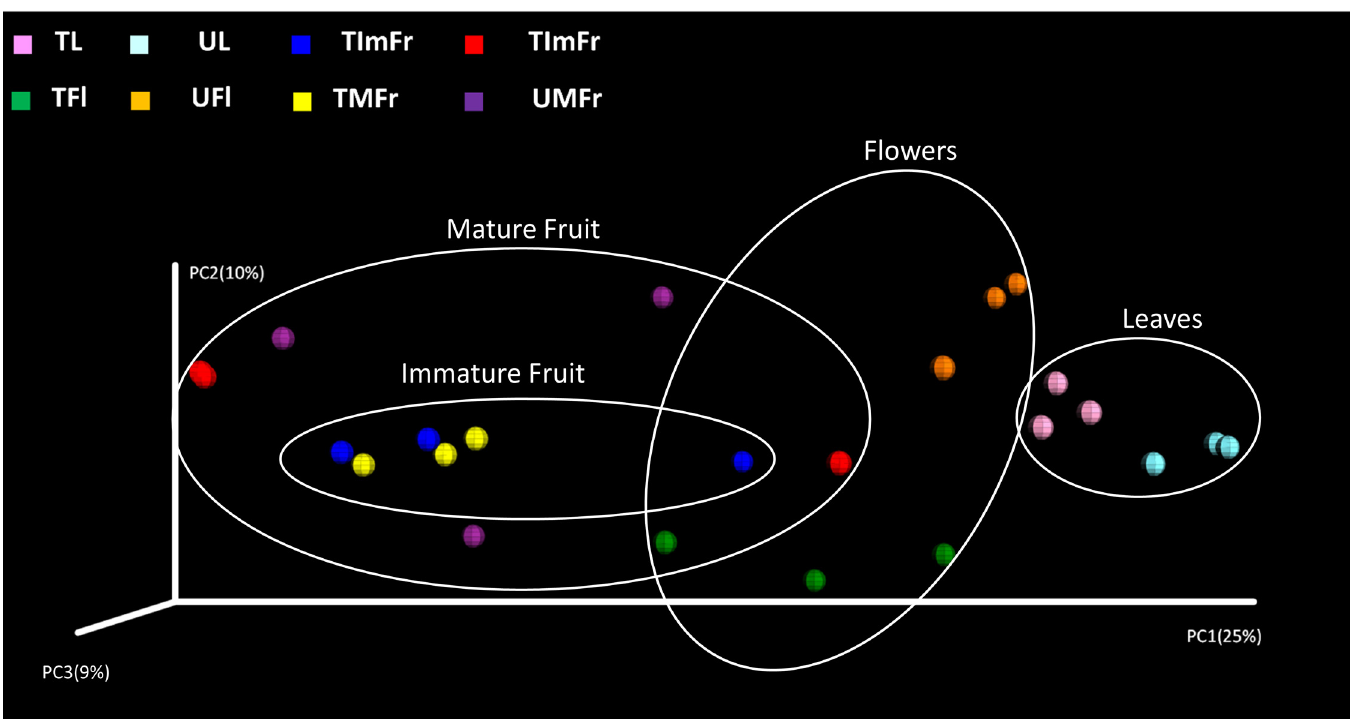
Fig 4. PCoA plot showing the results of the beta diversity analysis using the unweighted UniFrac metrics. White circles were used to indicate samples collected from the same organ, while colored spheres were used to differentiate treated (T) and untreated (U) samples of flowers (TFl and UFl), immature fruit (TIMFr and UIMFr), leaves (TL and UL), and mature fruit (TMFr and UMFr).